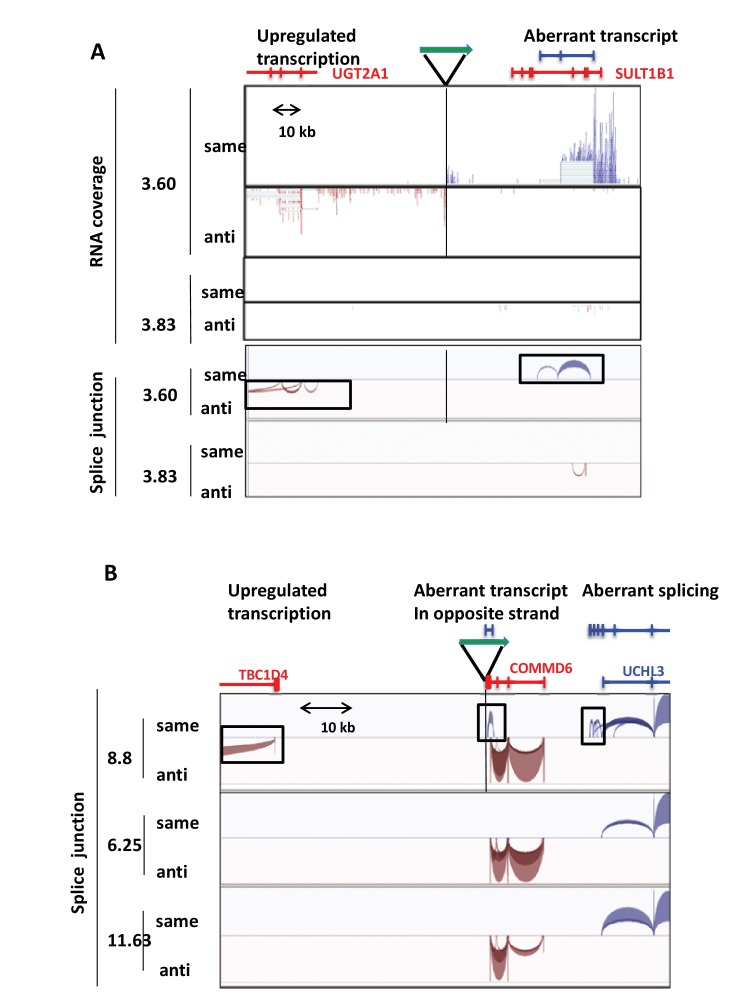
Examples of clone-specific aberrant transcription and splicing.(A) RNA-seq reads (upper panel) and splice junctions (boxed, lower panel) flanking the provirus in clone 3.60 and at the same genomic location in clone 3.83. Transcription in the same orientation as the proviral plus-strand is shown in blue; transcription in the antisense orientation to the proviral plus-strand in red. (B) Splice junctions flanking the provirus in clone 8.8 and at the same genomic location in clones 6.25 and 11.63, coloured relative to the proviral plus-strand as in A. The green arrows indicate the HTLV-1 proviral integration sites respectively in clone 3.60 (A) and clone 8.8 (B).